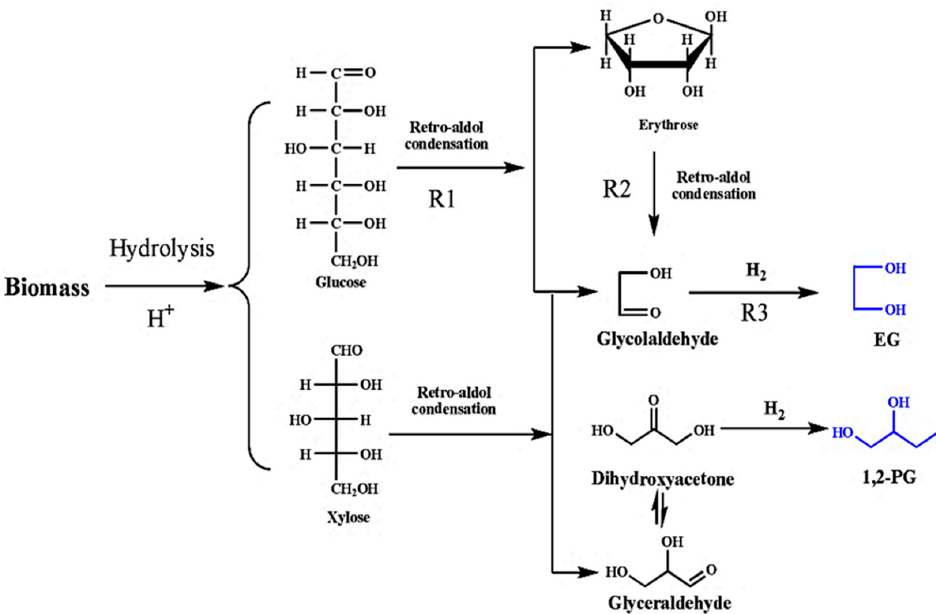
Figure 7. Illustrative diagram of the reaction for conversion of cellulose and hemicellulose to